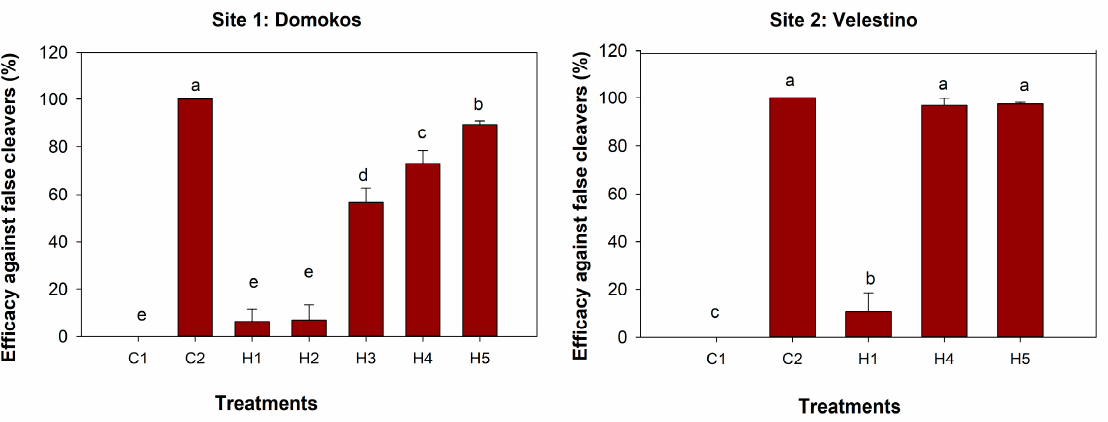
Figure 3. Efficacy of treatments (C1: untreated control, C2: weed-free control, H1: metsulfuron-methyl + bensulfuron-methyl, H2: pyroxsulam/florasulam + 2,4-D, H3: aminopyralid + florasulam, H4: bromoxynil + 2,4-D, and H5: halauxifen-methyl + florasulam) against false cleavers (%) at two sites. Values are presented as means of three replicates ± standard deviation. Mean values followed by different letters have statistically significant differences according to Duncan’s multiple range test at p < 0.05. F values of ANOVA: F = 366.854 *** (Site 1: Domokos) and F = 502.076 *** (Site 2: Velestino). *** significant at p < 0.001.